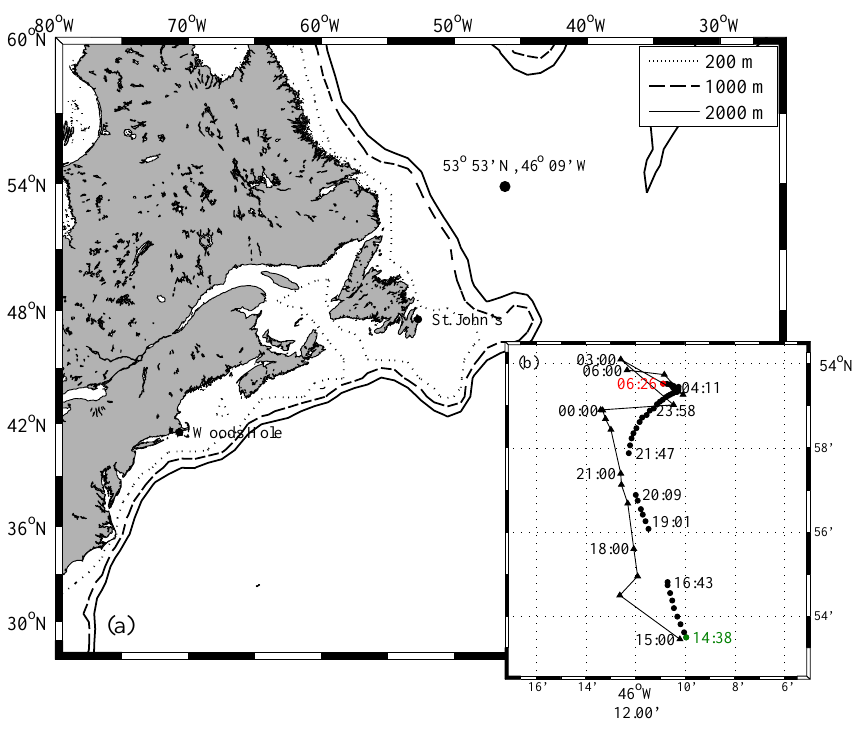
Fig. 1. (a) The 200m, 1000m, and 2000m depth contours are shown for the North Atlantic with the deployment location shown by the large black dot. Inset map (b) shows the ASIP profile locations (black dots) with the green dot being the first profile and the red dot showing the final profile. The ship locations at three hour intervals are shown by the black triangles. All times are in local mean